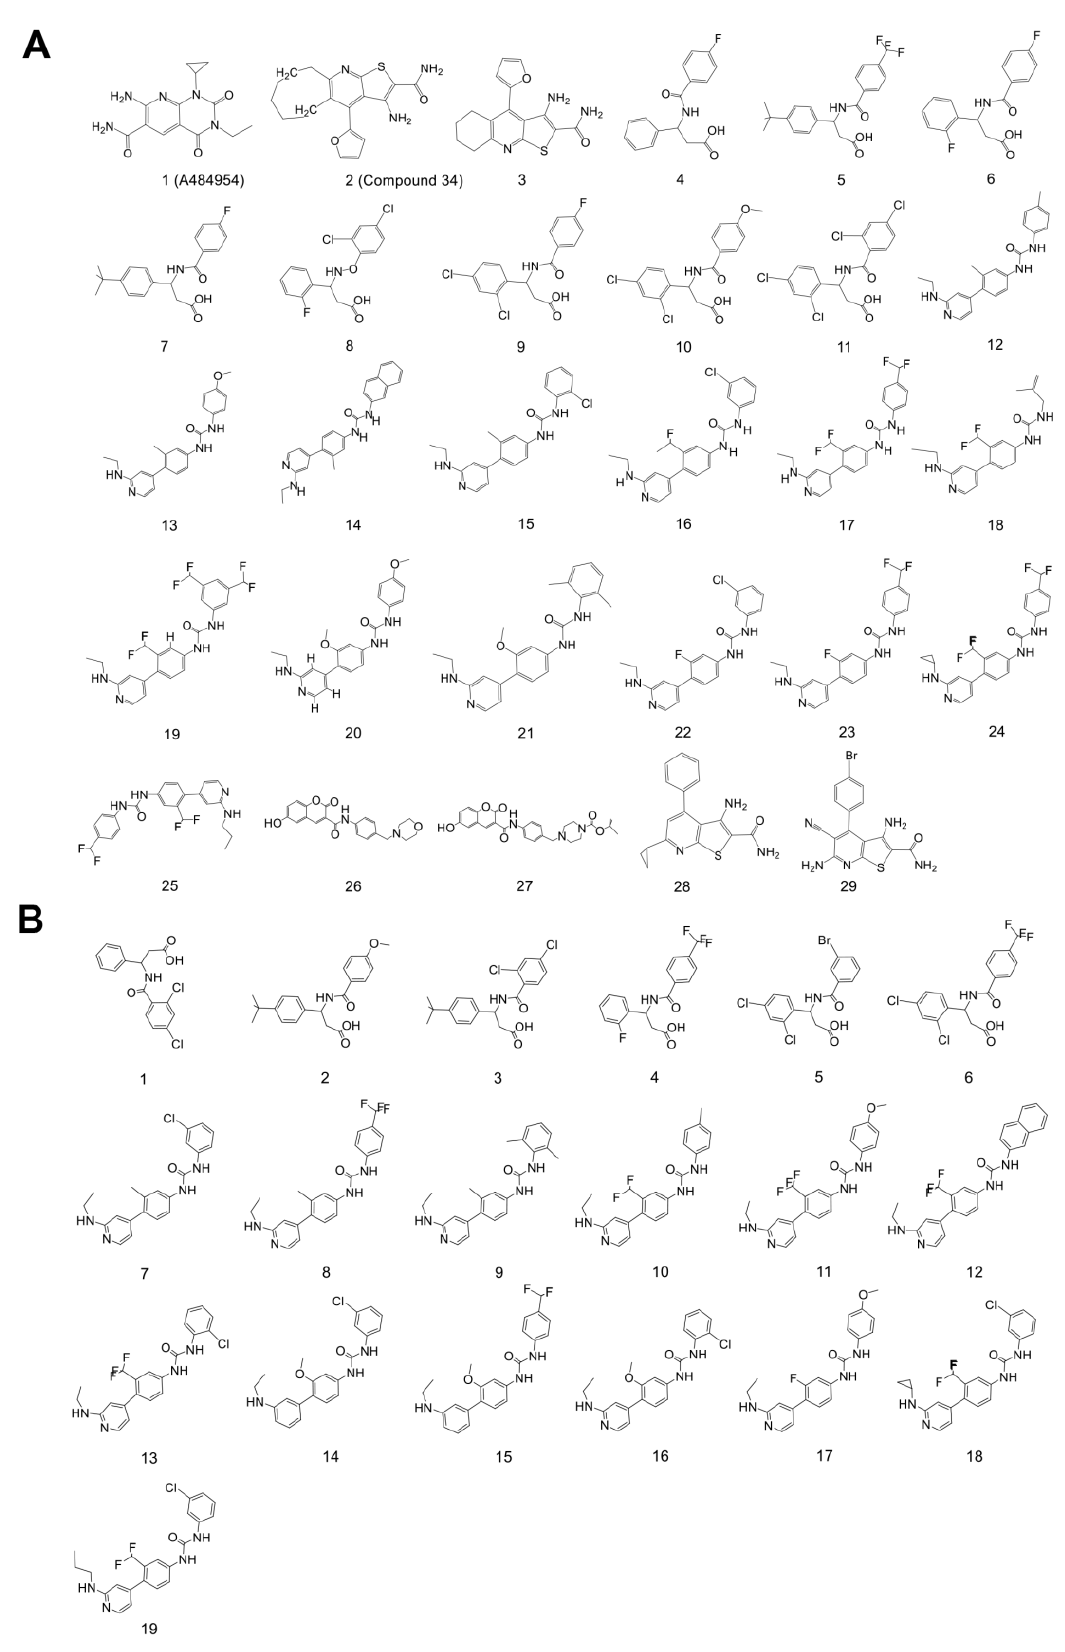
Figure 1. The structures of eEF2K-related chemicals. ( A ) Molecular structures of the training set. ( B ) Molecular structures of the test set, in which 2 , 3 , 12 , 13 , 16 , and 18 are inactive compounds.